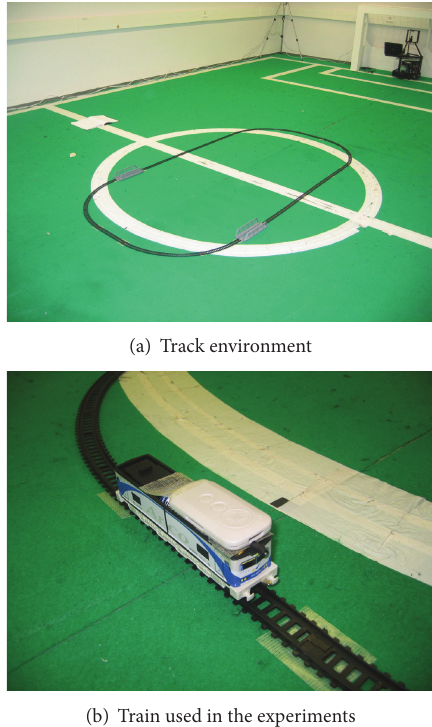
Figure 2: Track and train used in the experiments.